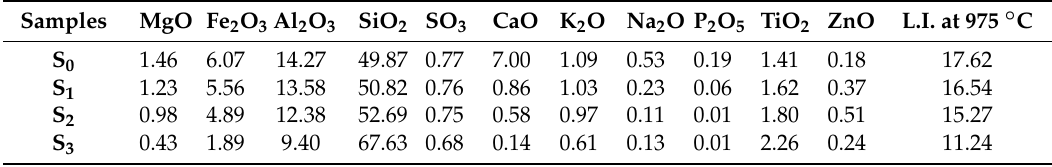
Table 1. Chemical analyses of raw material (S 0 ) and acid activated clay samples (S 1 , S 2 , S 3 ).